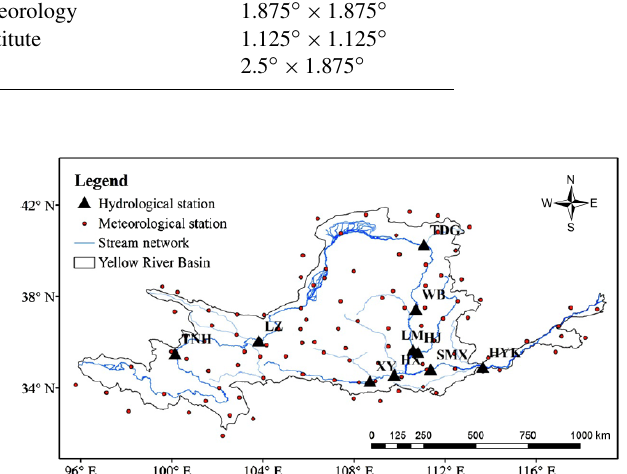
Figure 1. Distribution of 101 meteorological stations and ten hy- drological stations in